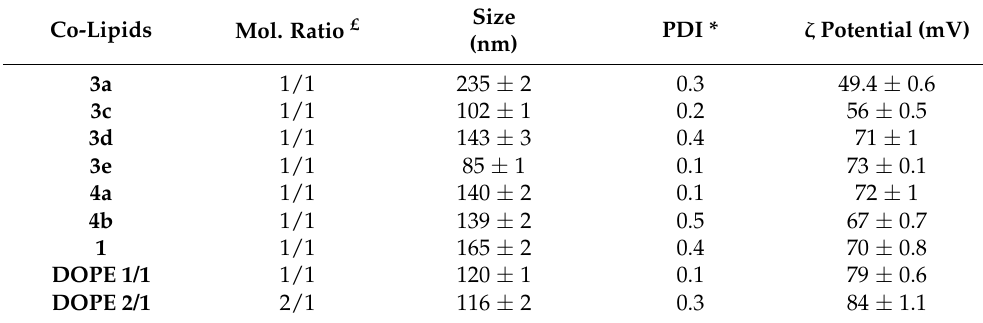
Table 1. Physicochemical characterization of 3b -based liposomes. Co-Lipids